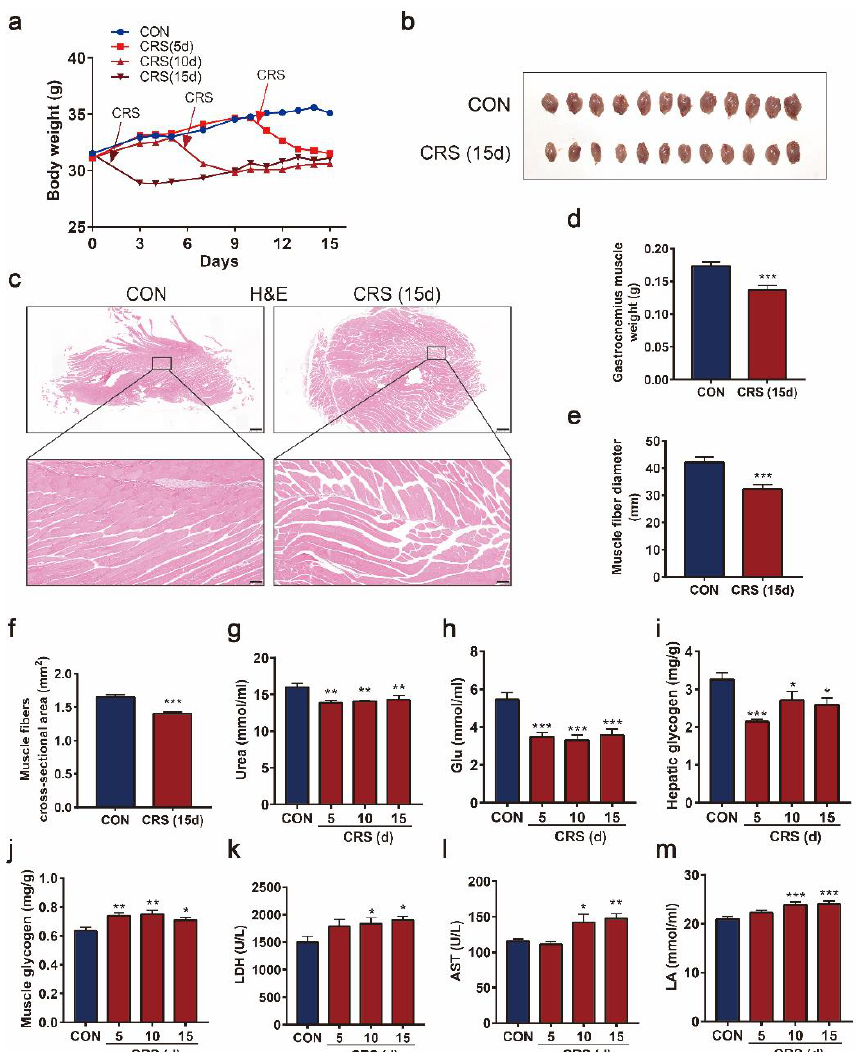
Figure 3. Effects of CRS on muscle function and fiber type. Effects of CRS on body weight ( a ) and anatomical observation of gastrocnemius muscles ( b ). Representative H&E-stained cross-sections ( c ) of gastrocnemius muscles (upper panel, scale bar = 500 μm; lower panel, scale bar = 100 μm). The weight of gastrocnemius muscles ( d ) (n = 12). The muscle fiber diameter ( e ), and the cross-sectional area ( f ) of gastrocnemius muscles, n = 3 per group. The serum levels of urea ( g ), Glu ( h ), LDH ( k ), AST ( l ), and LA ( m ). Hepatic ( i ) and muscle ( j ) glycogen in mice (n = 10–12). Data are presented as the mean ± SEM, * p < 0.05, ** p < 0.01, *** p < 0.001.